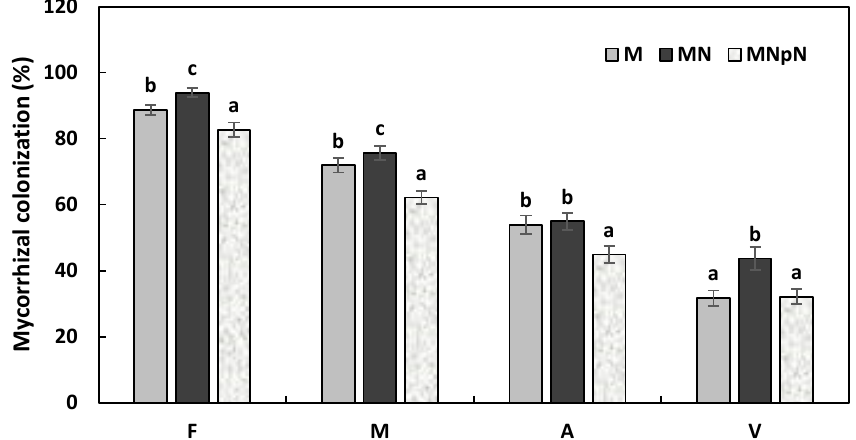
Figure 7. Mycorrhizal colonization of 56-day-old tomato plants inoculated with mycorrhizae and n-HAP and infected with M. incognita. Mycorrhizal parameters: F-mycorrhizal frequency, M—the intensity of mycorrhizal colonization, A—relative arbuscule richness, and V—vesicles. Within each mycorrhizal parameter, levels that are not connected with the same letter indicate statistically significant difference ( p < 0.05). Plants inoculated with AMF (M); plants infected with M. incognita and inoculated with AMF (MN); plants infected with M. incognita and treated with AMF and n-HAP